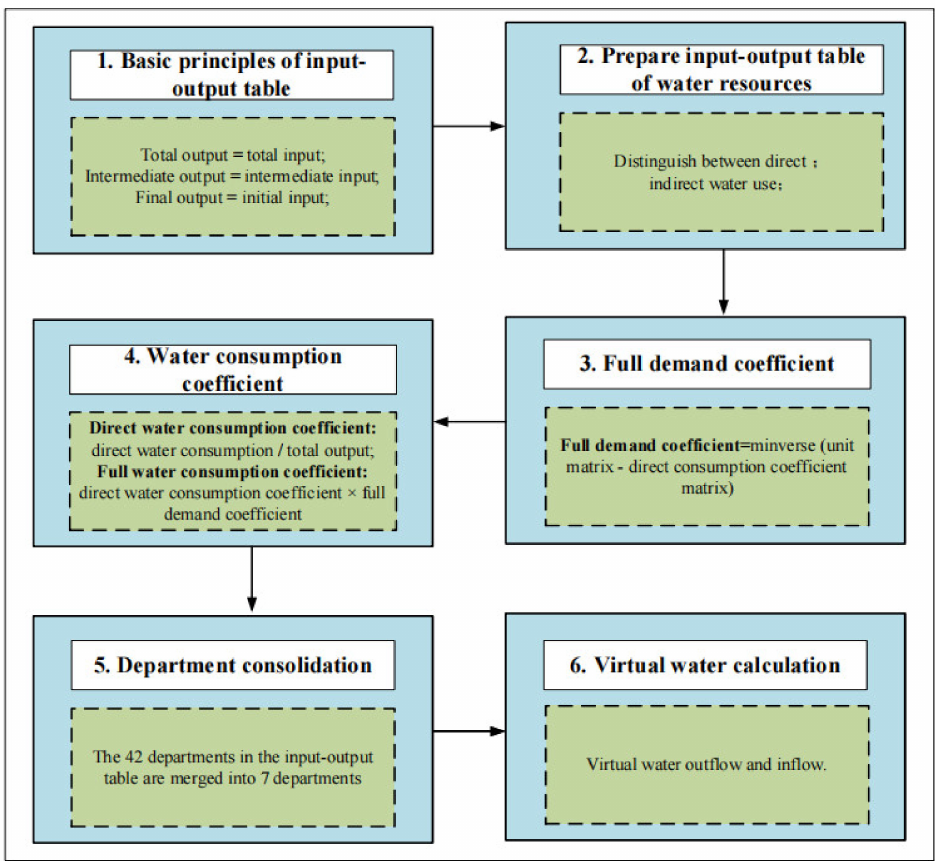
Figure 2. Model structure of virtual-flow-driving mechanism in the Yellow River